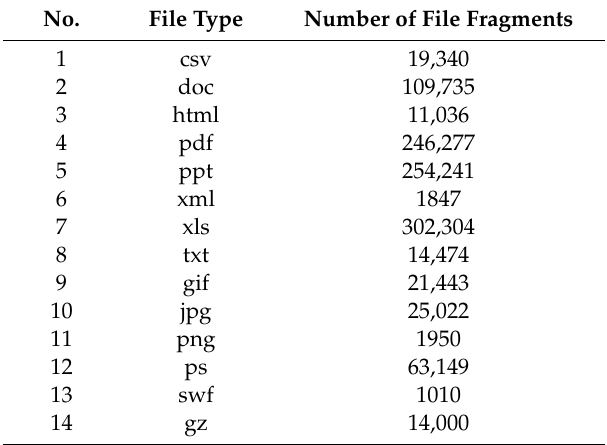
Table 2. Illustration of the dataset.